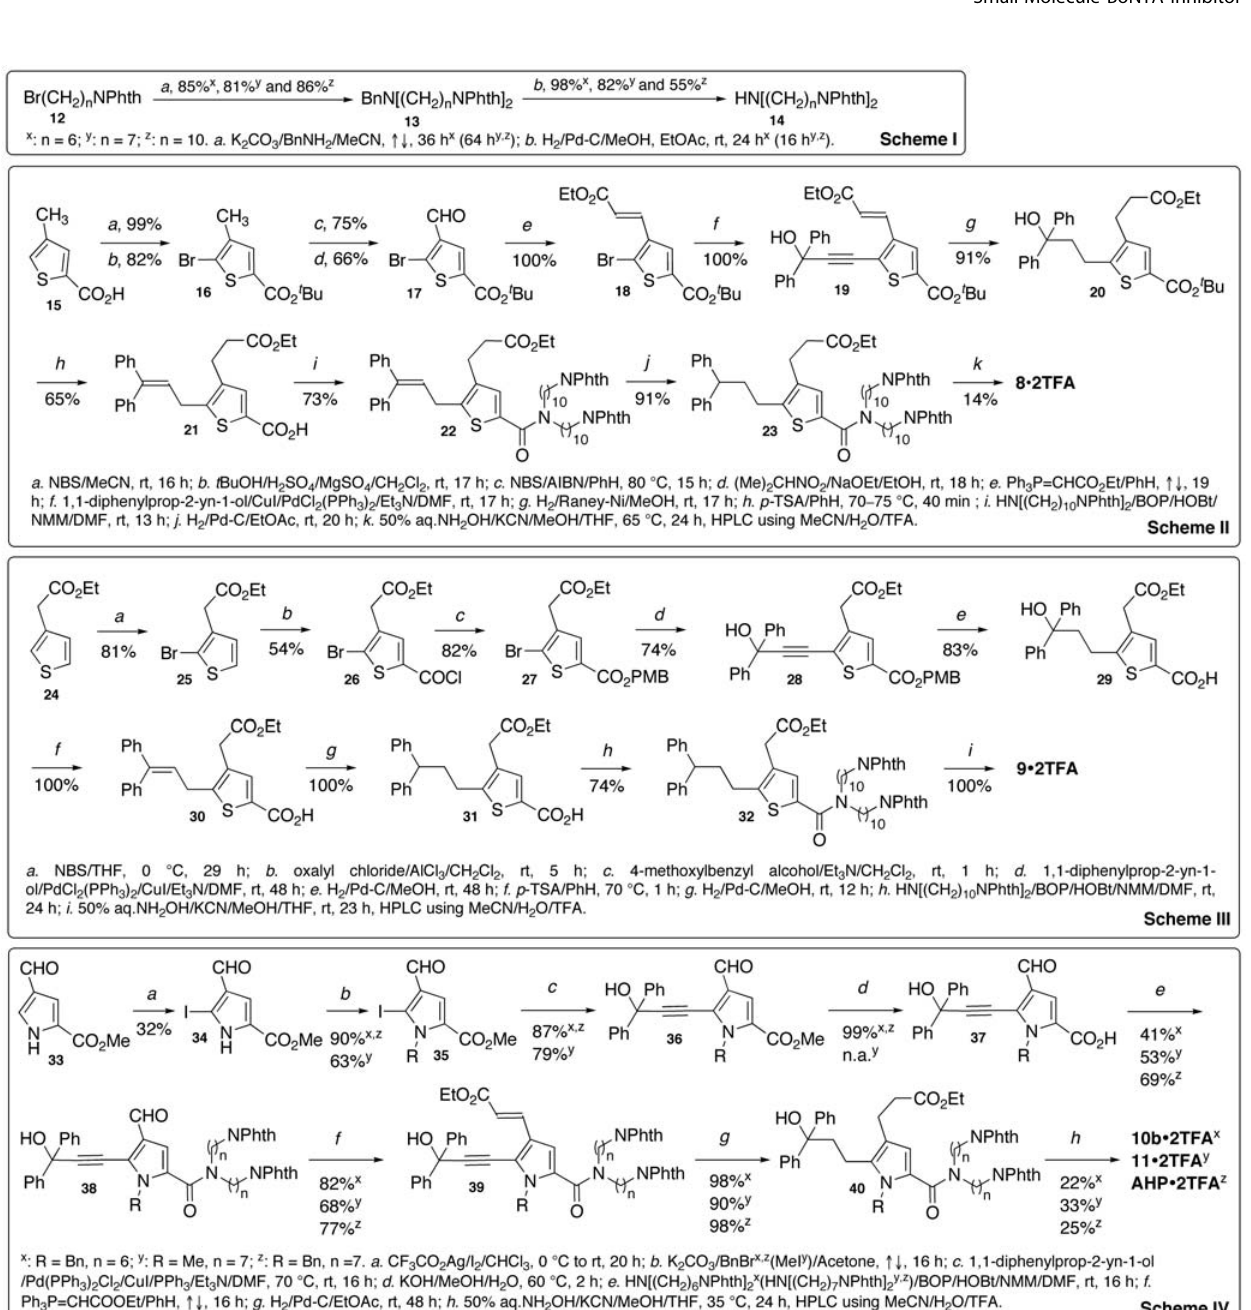
Figure 3. Syntheses of BoNTAe inhibitors 8, 9, 10b, 11, and AHP. Scheme I: synthesis of intermediate 14 ; Scheme II: synthesis of 8 ; Scheme III: synthesis of 9 ; Scheme IV: syntheses of 10b , 11 , and AHP